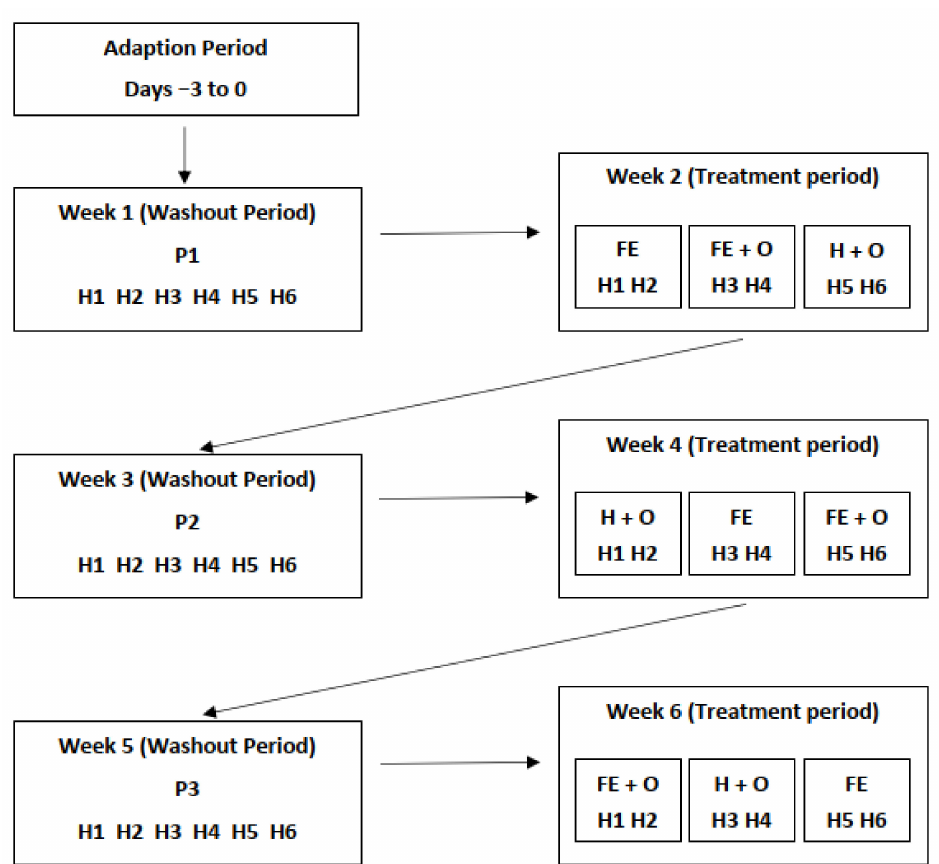
Figure 1. Illustration of the experimental design for the six-week study period. H1–H6 represents the 6 horses used; P1, P2 and P3 (cut pasture fed in stables during weeks 1, 3 and 5, respectively); FE—chopped ensiled Lucerne and Timothy; FE + O—chopped ensiled Lucerne and Timothy fed with whole oats; and H + O—hay fed with whole